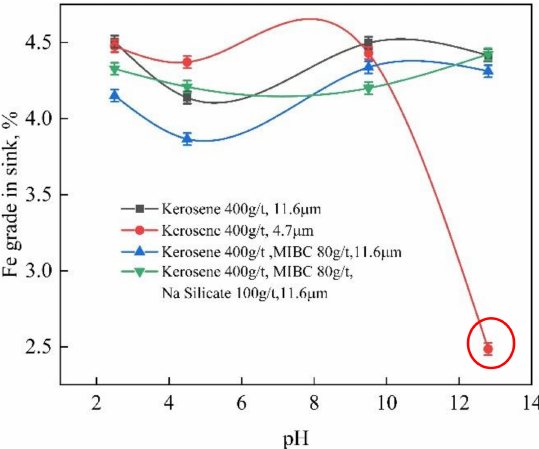
Figure 10. Iron grades in sink products of flotation using only kerosene for shungite of 4.7 µ m and flotations using only kerosene, MIBC + kerosene, MIBC + sodium silicate + kerosene for shungite of 11.6 µ m.